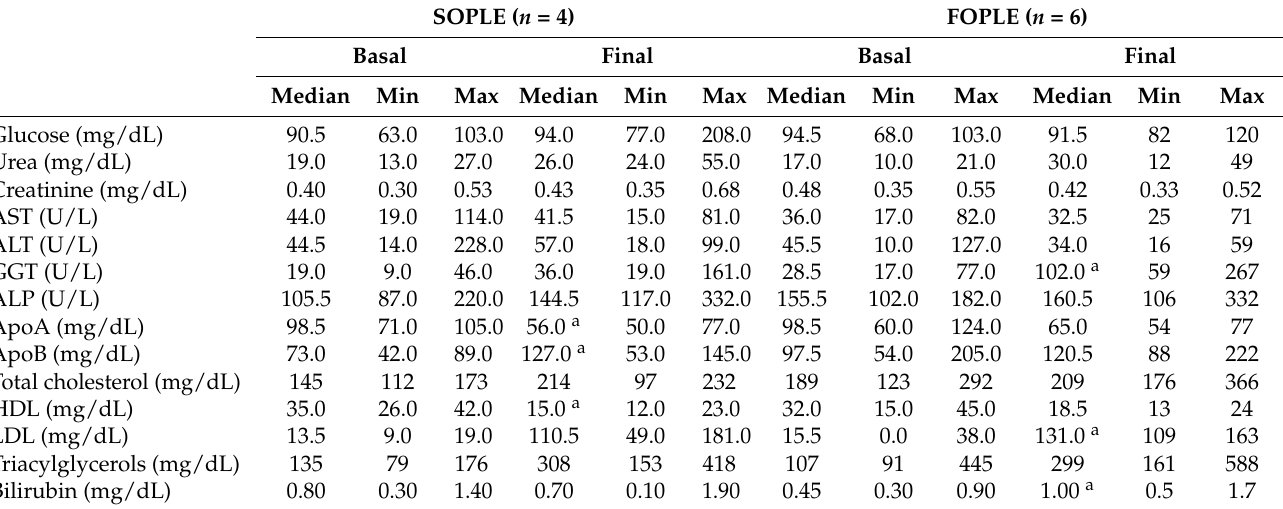
Table 3. General biochemistry and inflammatory biomarker values in plasma from subjects in SO- based parenteral lipid emulsion (SOPLE) and FO-based parenteral lipid emulsion (FOPLE) formula groups before and after the intervention.